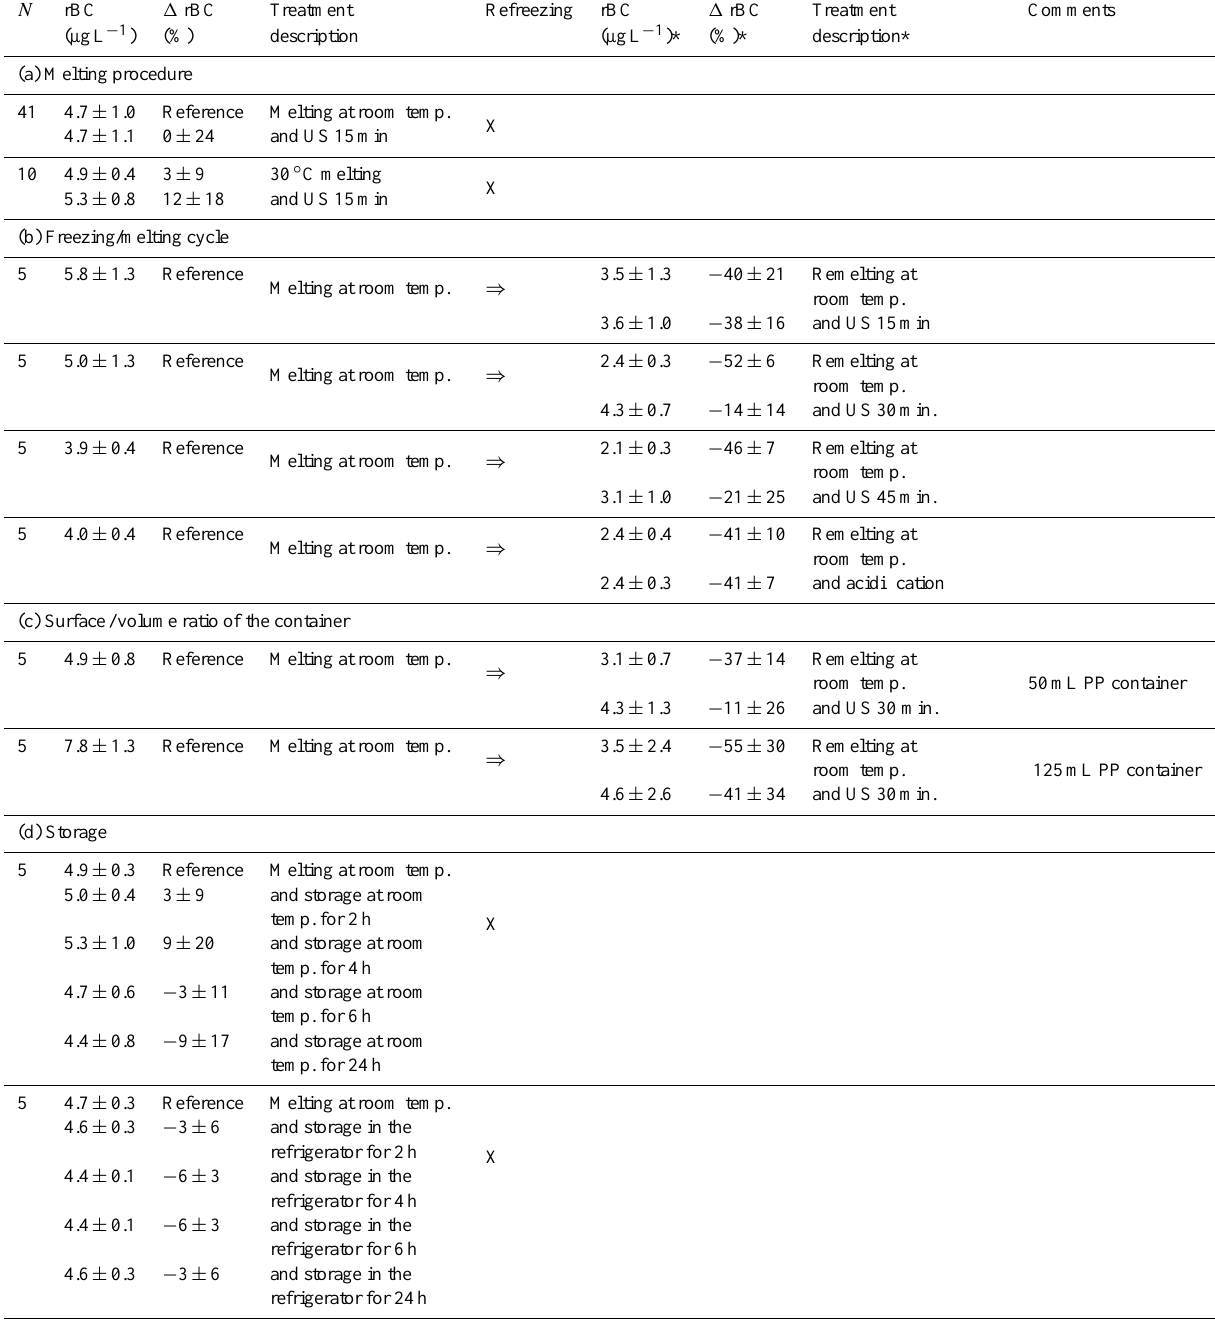
Table 1. rBC concentrations in snow samples from Col du Dôme (CDD, French Alps) determined after different treatment: (a) melting procedure, (b) freezing/melting cycle, (c) surface to volume ratios of the container, and (d) storage. rBC refers to the mean rBC ( ± 1 standard deviation) concentration calculated over N samples. 1 (rBC) refers to % variations in rBC concentrations between the reference and the treatment concerned. US stands for “ultrasonication”. * indicates data collected after refreezing and remelting